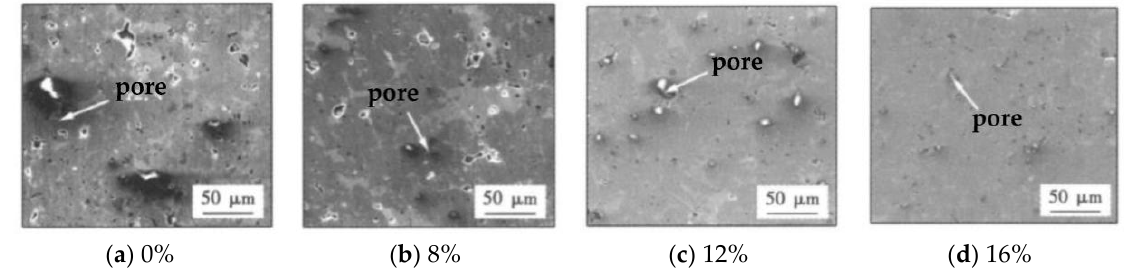
Figure 5. Microstructures of matrix with different content of pre-alloyed powder.